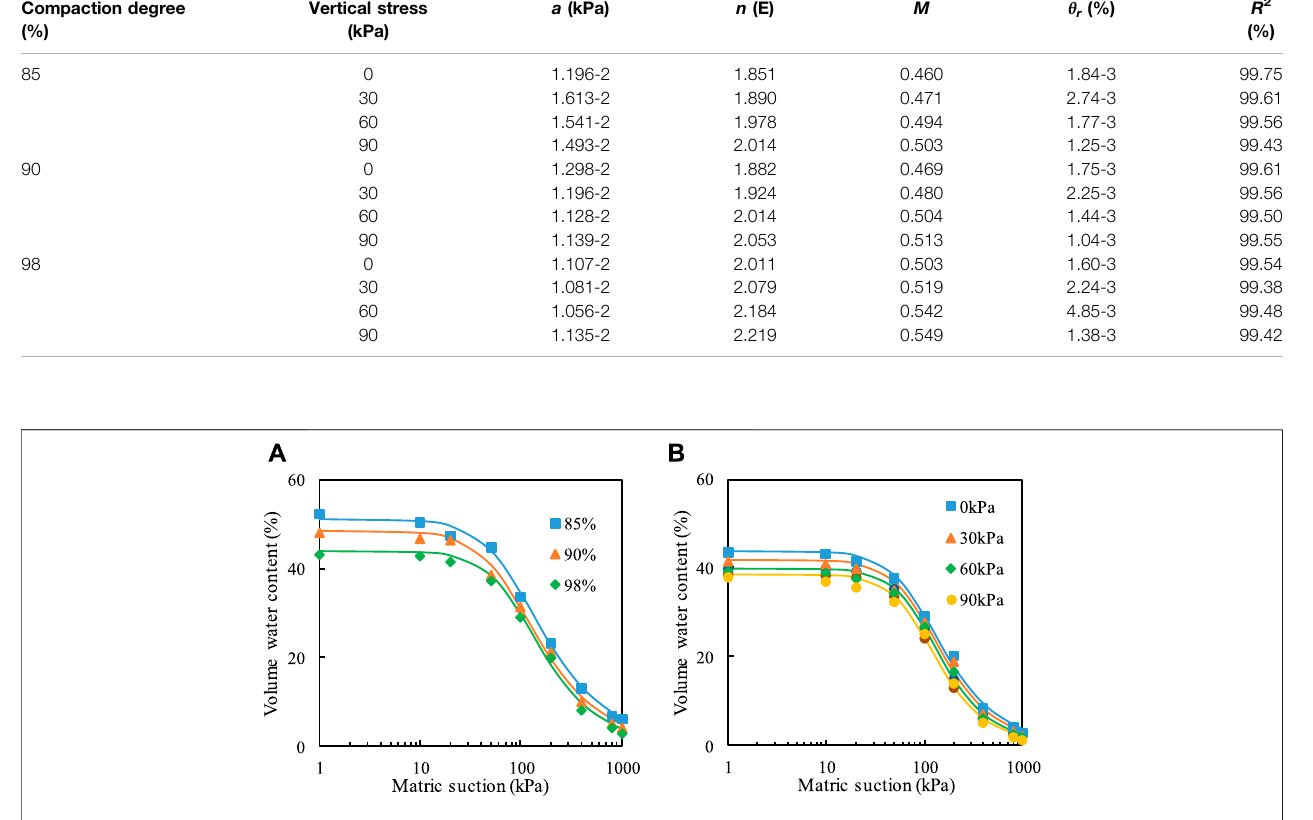
FIGURE 5 | SWCC results under different (A) compaction degrees and (B) stress